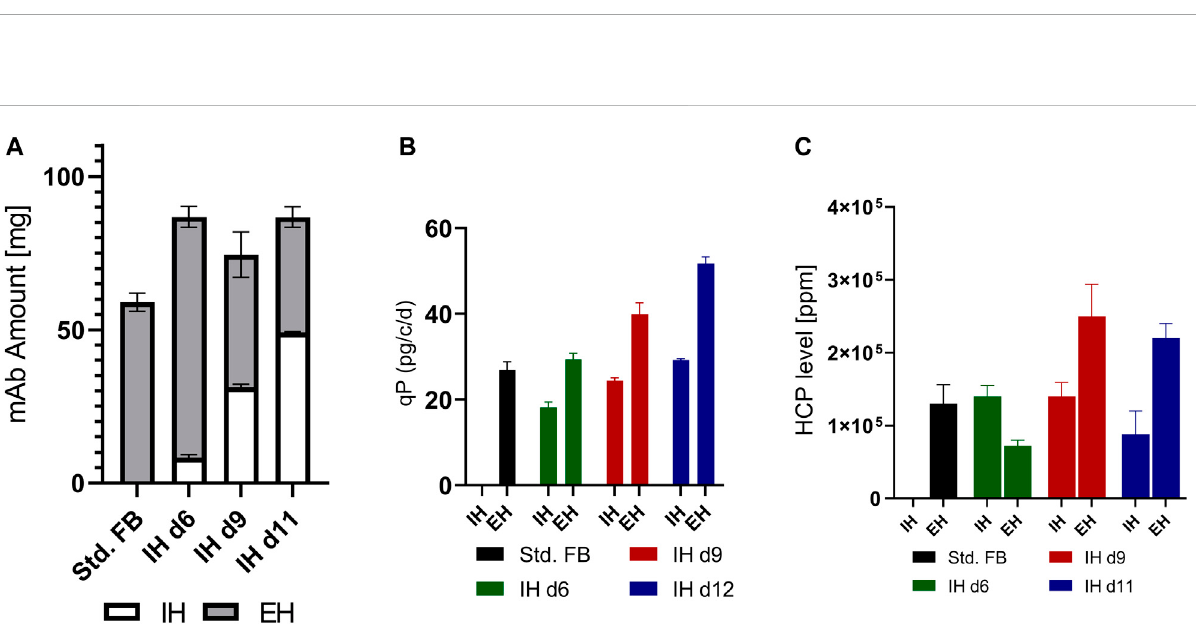
FIGURE 3 Supernatantanalysis fortheconductedsmall-scale screeningattherespectivetimepoints oftheintermediate harvest(IH)andtheend harvest(EH). (A) Cumulated amount of mAb for each approach overtime in the small-scale screening. (B) Mean cell-speci fi c productivity for the fi rst cultivation phase before IH (IH) and for the second phase between IH and EH (EH). Productivities for the control FB were calculated over the whole process duration until the EH. (C) Ratio of HCP content to expressed mAb for each approach at the time point of IH and